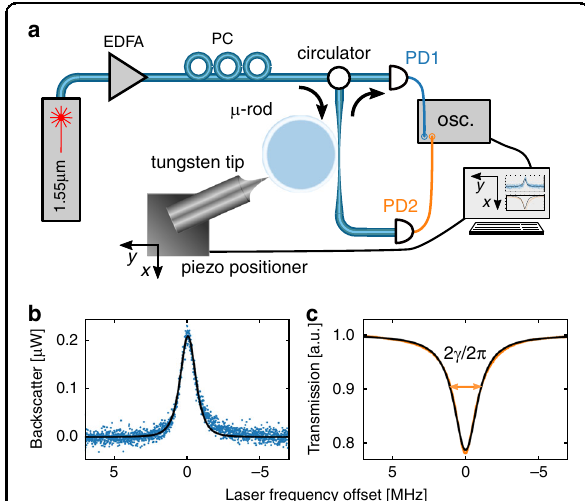
Fig. 2 Experimental setup and example measurements. a Optical circuitry, consisting of a fi bre-coupled external cavity diode laser (1.55 µm) ampli fi ed by an erbium-doped fi bre ampli fi er (EDFA), a polarisation controller (PC) to optimise the coupling to the desired resonator mode, a circulator to separate the propagation directions in the fi bre, and photodetectors to monitor the backscattering (PD1) and transmission of the microresonator (PD2). The tungsten tip near- fi eld probe was fi xed to a piezo positioner. Example backscattering b and transmission c spectra with fi tted Lorentzians (black) for one position of the near- fi eld probe, showing the transmission linewidth 2